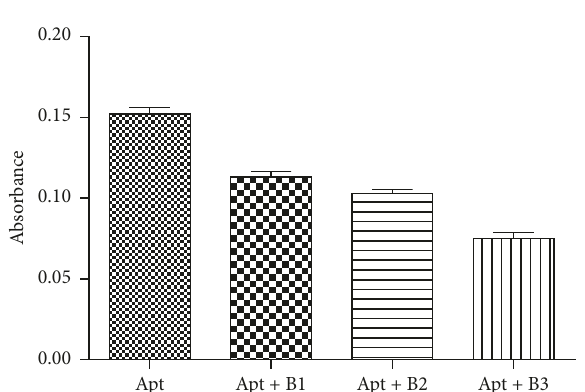
Figure 2: Blockade of peroxidase activity of DNAzyme-aptamer by B1, B2, and B3 sequences. Apt: DNAzyme-aptamer; B: blocker complementary sequence.